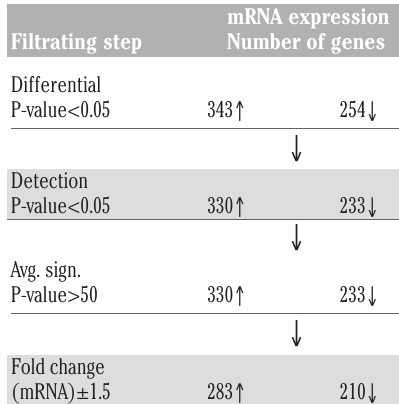
Table 1. Number of differentially expressed genes after different filtering